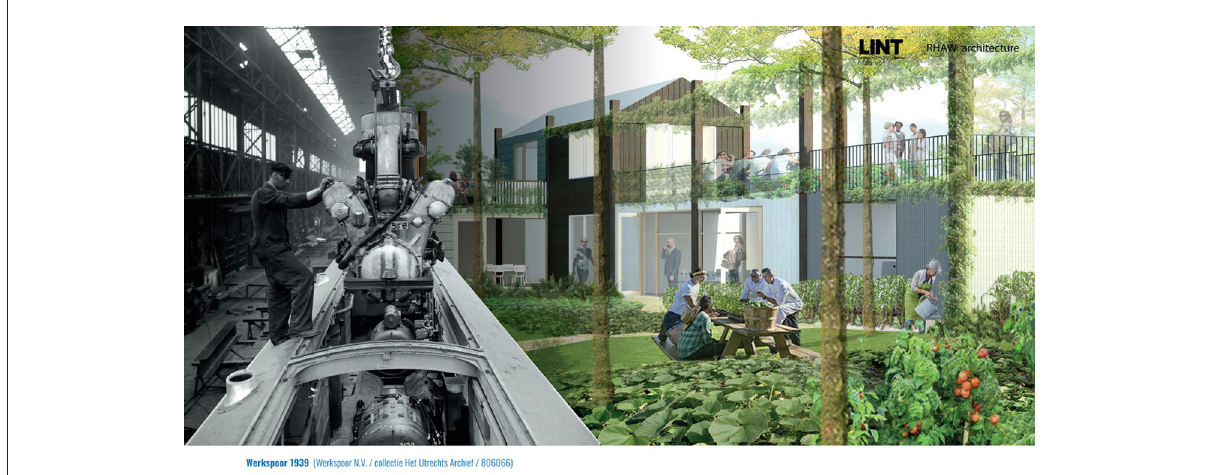
FIGURE3 Illustration taken from the website of the European Regional Development Fund showing the past, present, and future of het Werkspoorkwartier . Source: Werkspoorkwartier: Creatief Circulair Maakgebied | Het project (efro-wsk.nl).